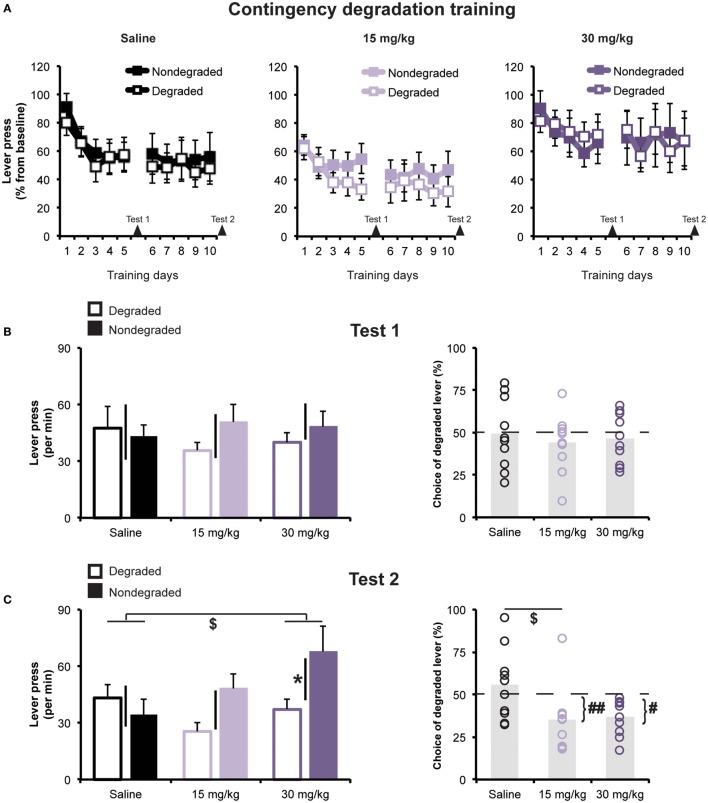
Contingency degradation (A) Mean (±SEM) rates of lever pressing during contingency degradation training. Lever pressing rates are expressed as % of baseline. Arrows indicate test days (B) responses during Extinction Test 1. Left panel: mean press rate (±SEM) on lever for which the contingency was Degraded or Non-degraded. Black bars represent ±SEM of within-subject difference score (Non-degraded–Degraded). Right panel: mean (±SEM) percentage of all lever presses performed on the Degraded lever. (C) Responses during Extinction Test 2. Left panel: mean press rate (±SEM) on lever for which the contingency was Degraded or Non-degraded. *p < 0.05 Degraded vs. Non-degraded. $p < 0.05 vs. saline-treated group. Black bars represent ±SEM of within-subject difference score (Non-degraded–Degraded). Right panel: mean (±SEM) percentage of all lever presses that were performed on the Degraded lever. $p < 0.05 vs. saline-treated group. #p < 0.05 and ##p < 0.01 vs. 50%.